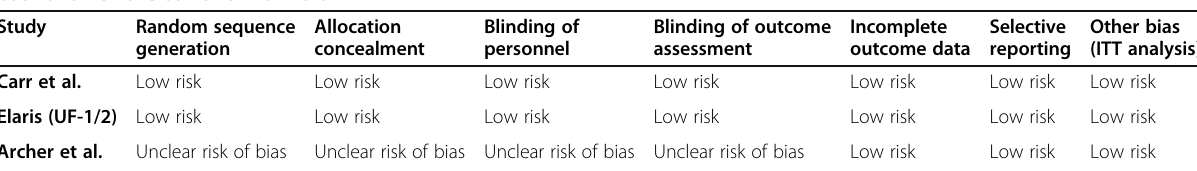
Table 4 Risk of bias analysis Cochrane Risk of Bias Review for RCTs Study